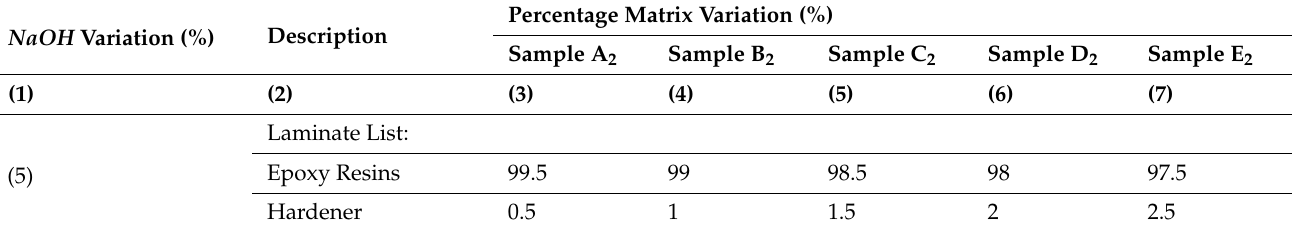
Table 4. Experimental design for various matrix polymer composite materials with variations in NaOH sample C 1 as a